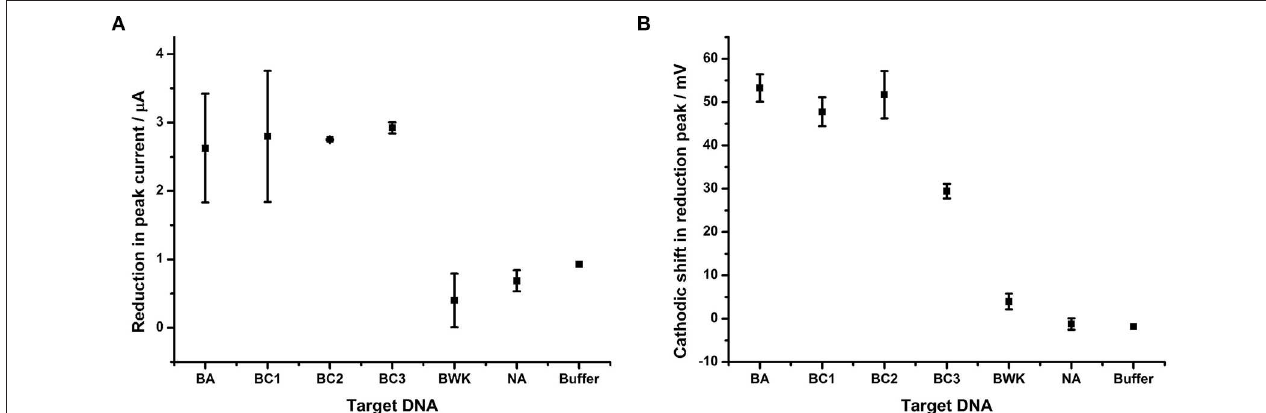
FIGURE 6 | Impact of DNA hybridization on peak current under oxygenated conditions in comparison to reduction peak shift. Probe BA-1 was hybridized to 24 bp DNA strands that were either fully complementary (BA) or contained 1 (BC1), 2 (BC3, BC2), 7 (BWK) nucleotide changes respectively. The response in terms of (A) showing reduction in peak current and (B) the shift in the potential of the reduction peak, respectively. All measurements were made by DPV (scan − 0.4V to − 0.75V; 50mV s − 1 ) vs. SCE in 10mM Tris buffer pH 8, 0.5M NaCl. Points represent an average of the responses shown by three replicate electrodes (error bars are 95% confidence limits from this